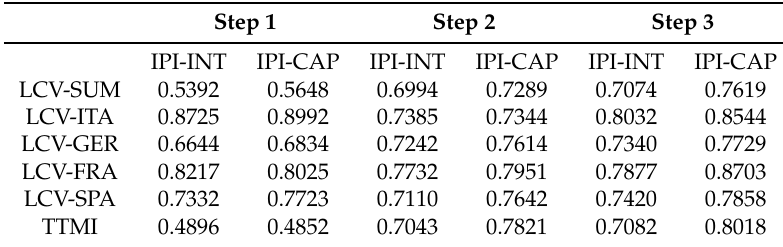
Table A21. Comparison of mean absolute error with expanding window applied to conditional var with three variables. The forecast windows expands itself from 2008:01 to 2018:12. The ratio between MAEs is shown. A value less than one shows an improvement over